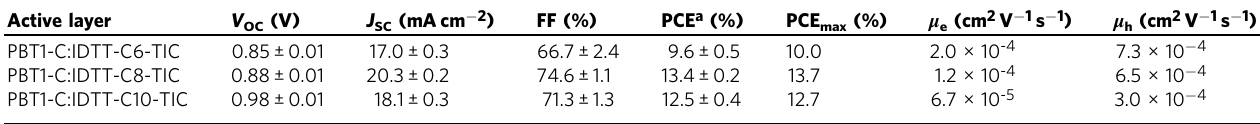
a The average parameters were calculated from 20 independent